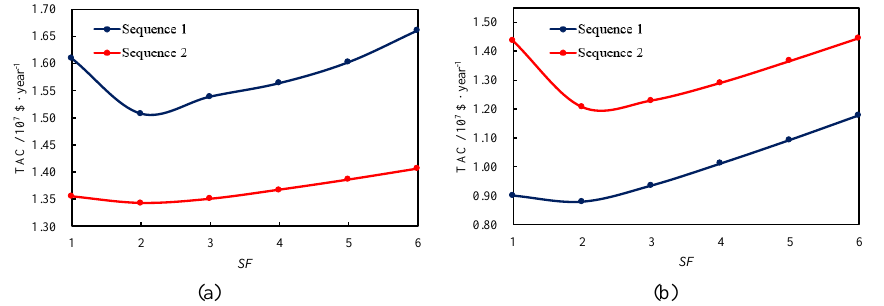
Figure 4. Variation of the total annualized costs (TACs) along the solvent-to-feed ratio with solvents AN ( a ) and CB ( b ). Figure 4 shows that the TACs of all distillation sequences decrease first and then in- crease along the solvent-to-feed ratio. By comparing TACs corresponding to different sol- vents, solvent-to-feed ratios and extractive distillation sequences, the minimum TAC is achieved when solvent is CB, solvent-to-feed ratio is 2, and Sequence 2 is applied. 4. Optimization of Reaction and Extractive Distillation System In chemical process, the mixture to be separated by distillation sequence is generally the reactor effluent; reactor operating conditions affect its composition, and further affect the separation system. When the extractive distillation is used, solvent and the distillation sequence affect the system’s cost. To achieve economic optimization, all these factors should be considered together. For a reactor with m reactions and n components ( A 1 , A 2 , …, A n , arranged in the order of decreasing volatility), all reactions can be expressed as Equation (17).